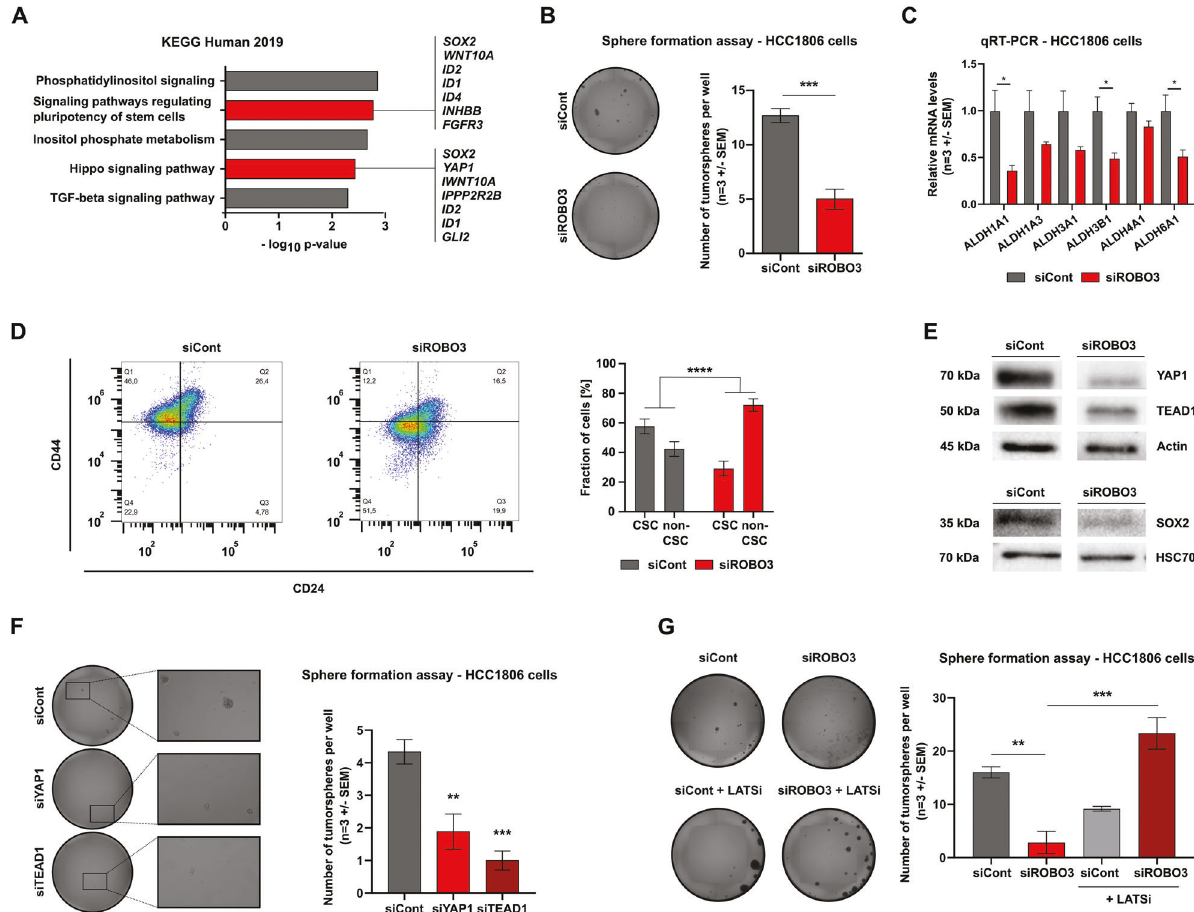
Fig. 5 ROBO3s loss impairs the Hippo pathway and CSC characteristics. A Pathway enrichment analysis (EnrichR web tool) showing that genes signi fi cantly downregulated upon ROBO3 knockdown are enriched for the KEGG 2019 signature “ Signaling pathways regulating pluripotency of stem cells ” and “ Hippo signaling pathway ” . B Tumorsphere formation assay of control and siROBO3 treated HCC1806 cells (left panel). Quanti fi cation of tumorspheres number normalized to the control condition (right panel). C qRT-PCR showing a decrease of stem cell speci fi c ALDH genes expression in siROBO3 treated HCC1806 cells. D Measurement of CD24 and CD44 positive population by fl uorescence activated fl ow cytometry in HCC1806 cells treated with siCont or siROBO3. E Western blot of HCC1806 cells showing protein levels of SOX2, YAP1 and TEAD1 upon ROBO3 knockdown. F Tumorsphere formation assay of siControl, siYAP1 or siTEAD1 treated HCC1806 cells (left panel). Quanti fi cation of tumorspheres number normalized to the control condition (right panel). G Tumorsphere formation assay of siCont and siROBO3 treated HCC1806 cells, without or with LATSi (10 μΜ , left panel). Quanti fi cation of tumorspheres number normalized to the control conditions (right panel). B , D , E , F and G : Error bars represent mean ± SEM of three biological replicates, unpaired t-test or chi2-test G . * p < 0.05; ** p < 0.01; *** p <